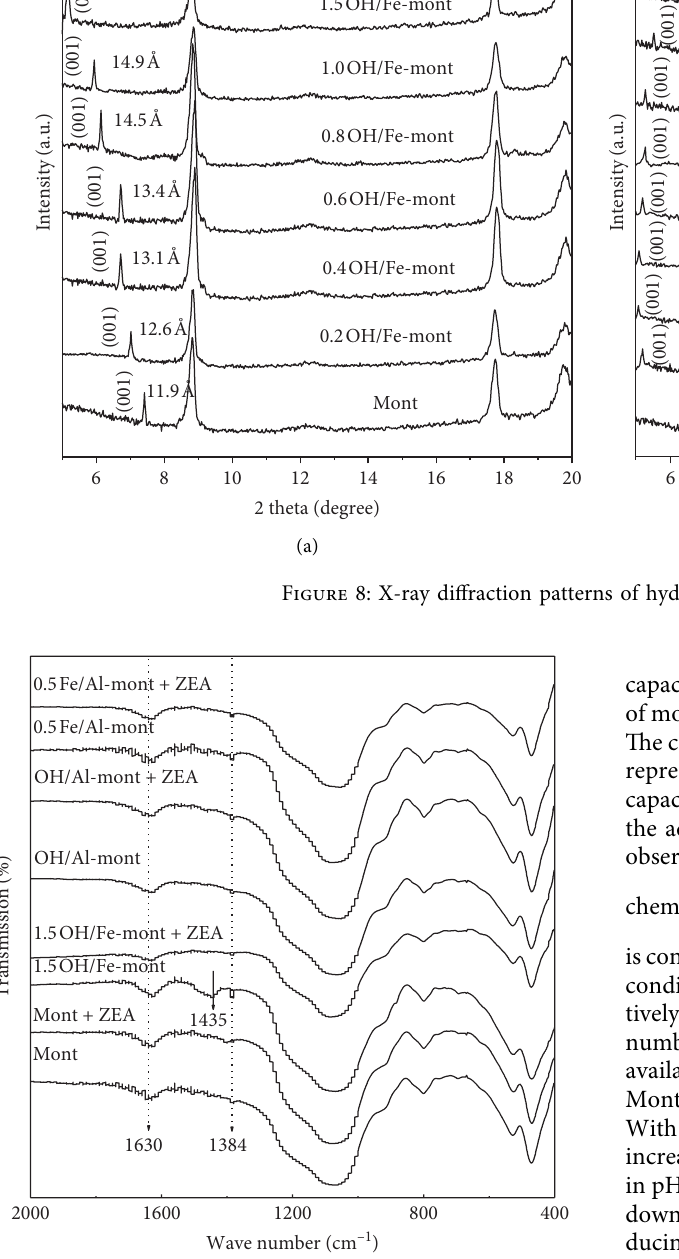
Figure 9: FT-IR spectra before and after ZEA adsorption (+ZEA represents adsorption) on hydroxyl-Fe-Al-pillared